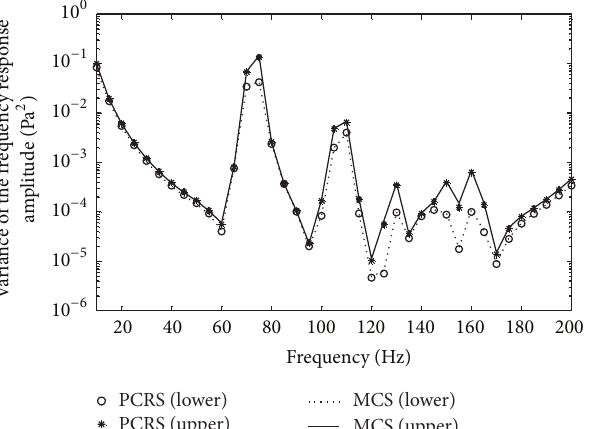
Figure 14: The lower and upper bounds of variance of the frequency response amplitude at node 𝑅2 calculated by PCRS and MCS in the frequency band 𝑓 = 10 ∼